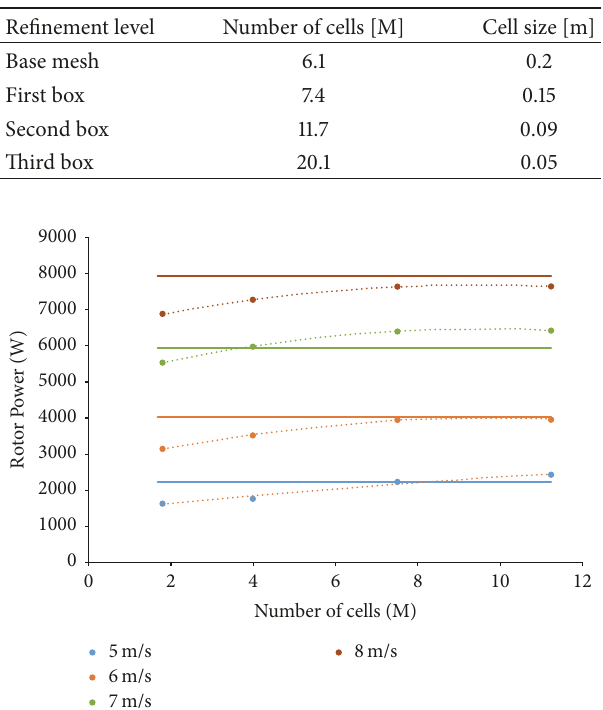
Table 4: Mesh characteristics.